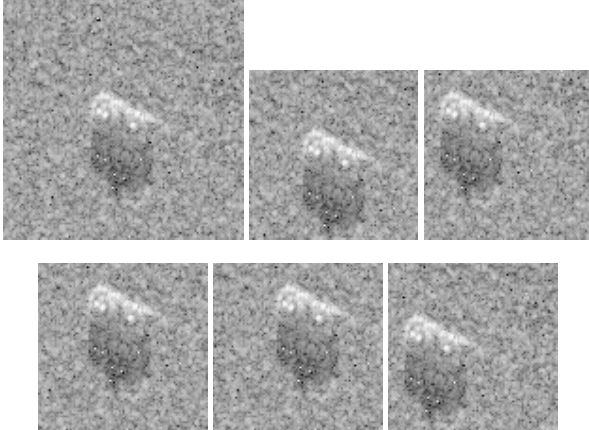
Figure 8. Original image and five randomly generated patches.